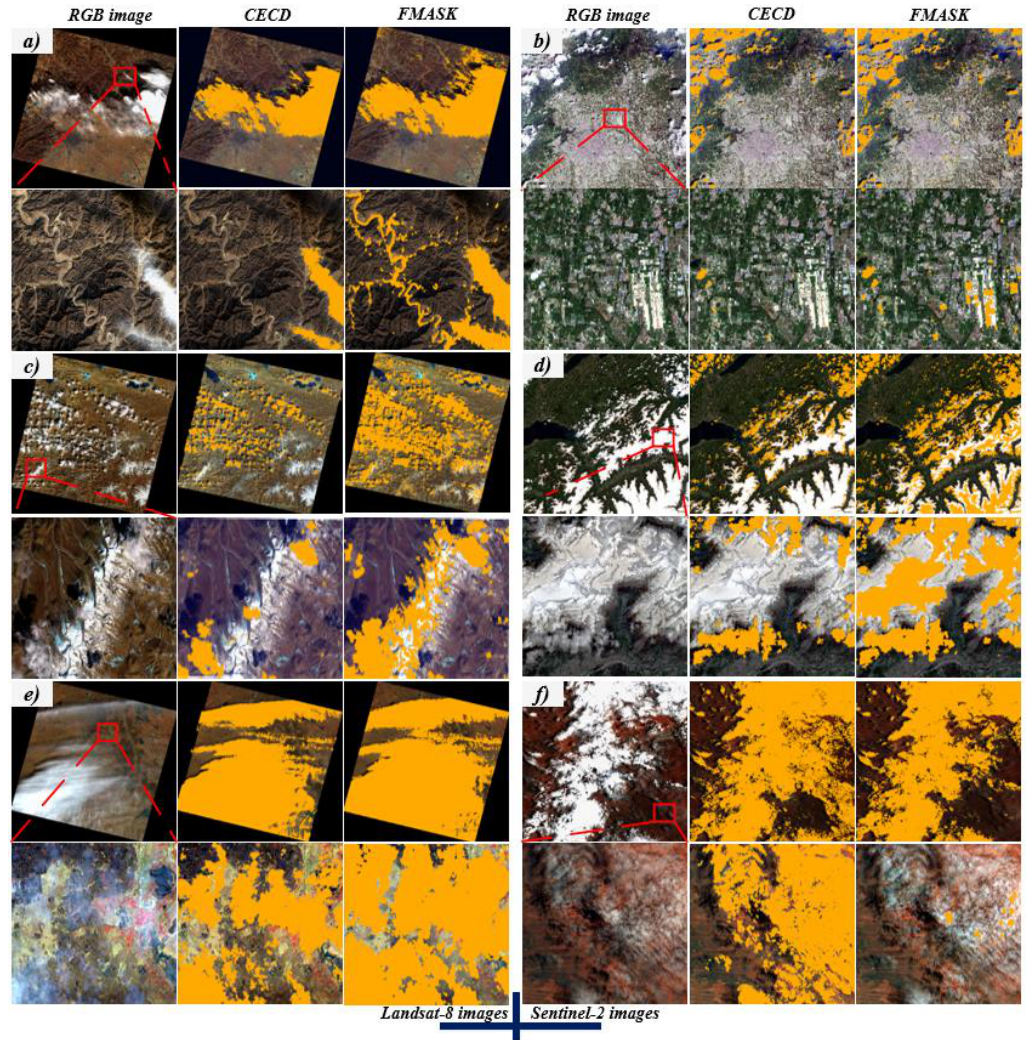
Figure 6. Comparison of cloud-detection results obtained by applying the CECD and FMASK methods to three typical Landsat-8 scenes and three typical Sentinel-2 scenes. ( a , c , and e ) are Landsat-8 images corresponding to site c, b, and a; ( b , d , and f ) are Sentinel-2 images covering sites c, k, and g. ( a , b ) are clouds over bright impervious surface-cover types; ( c , d ) are clouds over mixed snow, bright bare lands/ forest areas; ( e , f ) are thin clouds over barren lands. For each scene, the upper row shows a complete color-composited image and the cloud masks for the two algorithms; the lower images are enlargements of the corresponding upper images. Clouds in the cloud masks are colored orange.